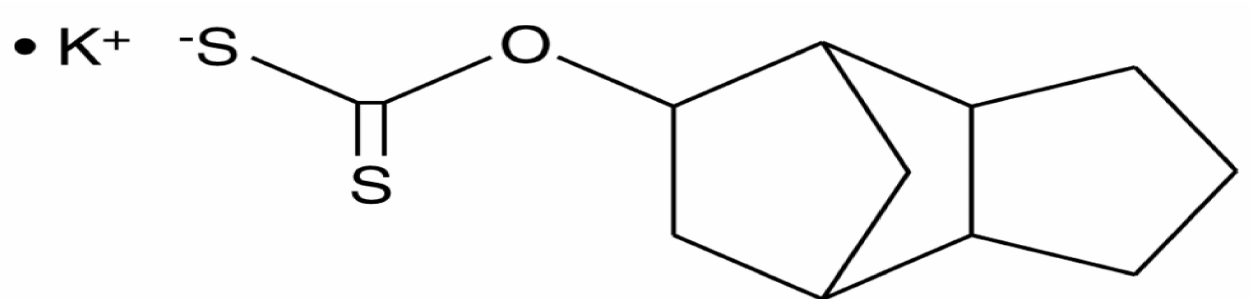
Figure 1. Structure of tricyclodecan-9-yl xanthogenate (D609). Protein carbonyl, protein-bound hydroxynonenal (HNE) (a lipid peroxidation prod- uct), 3-nitrotyrosine (3-NT), and cytochrome-c release were all significantly lower in oxidant-treated brain mitochondria isolated from saline-injected gerbils [18]. Moreover, D609 therapy successfully maintained the (reduced glutathione/oxidized glutathione) GSH/GSSG ratio of oxidant-treated mitochondria. D609-treated glutathione reductase (GR), glutathione peroxidase (GPx), and glutathione S-transferase (GST) gerbils improved brain growth, which reinforced the concept that D609 works as GSH. The anti-apoptotic properties of this molecule are studied as possible therapeutics for oxidative stress-induced neurodegenerative diseases, such as AD